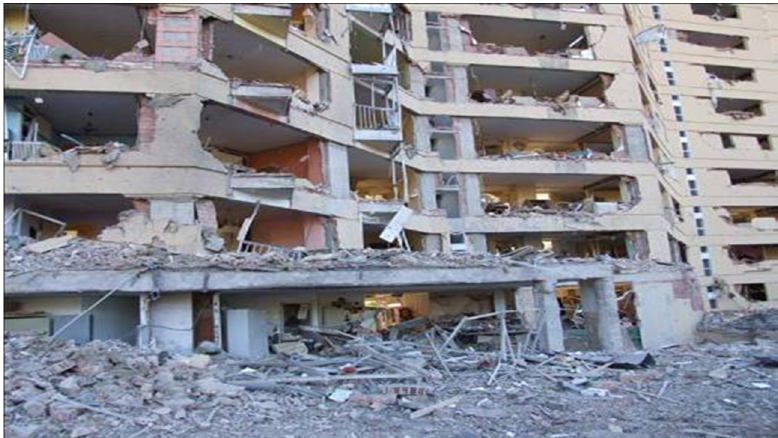
Figure 1. Structure damaged by a Vehicle-Borne Improvised Explosive Device (VBIED) explosion (Burgos, 2009).